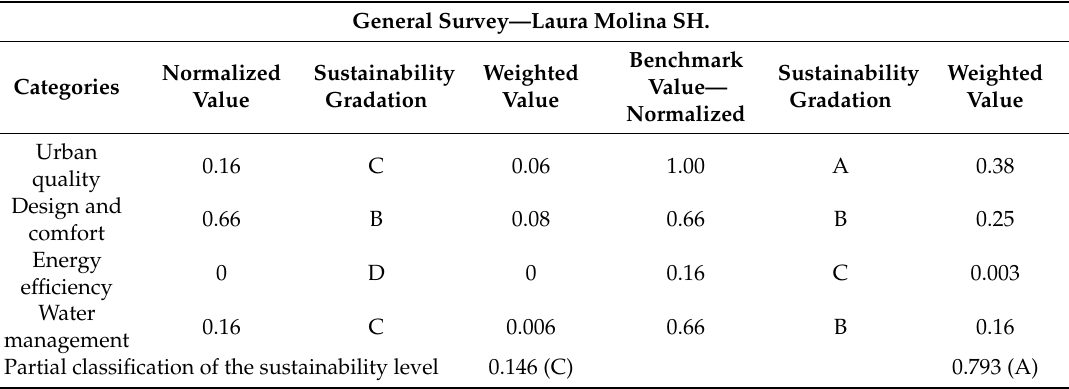
Table 8. Evaluation profile of Laura Molina SH—ideal Casa Azul Label.